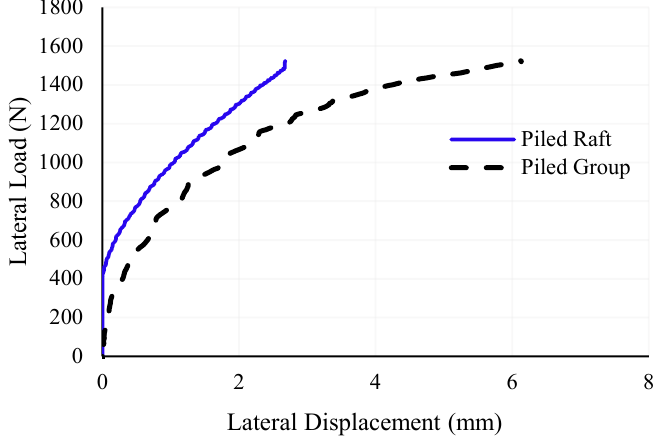
Figure 25. 17-piled raft vs. 17-pile group response under lateral load.